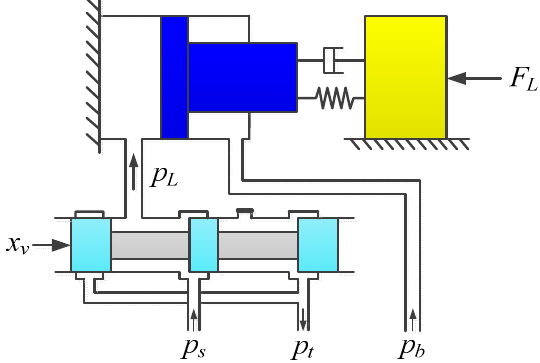
Figure 2. Schematic diagram of the servo valve control hydraulic cylinder.